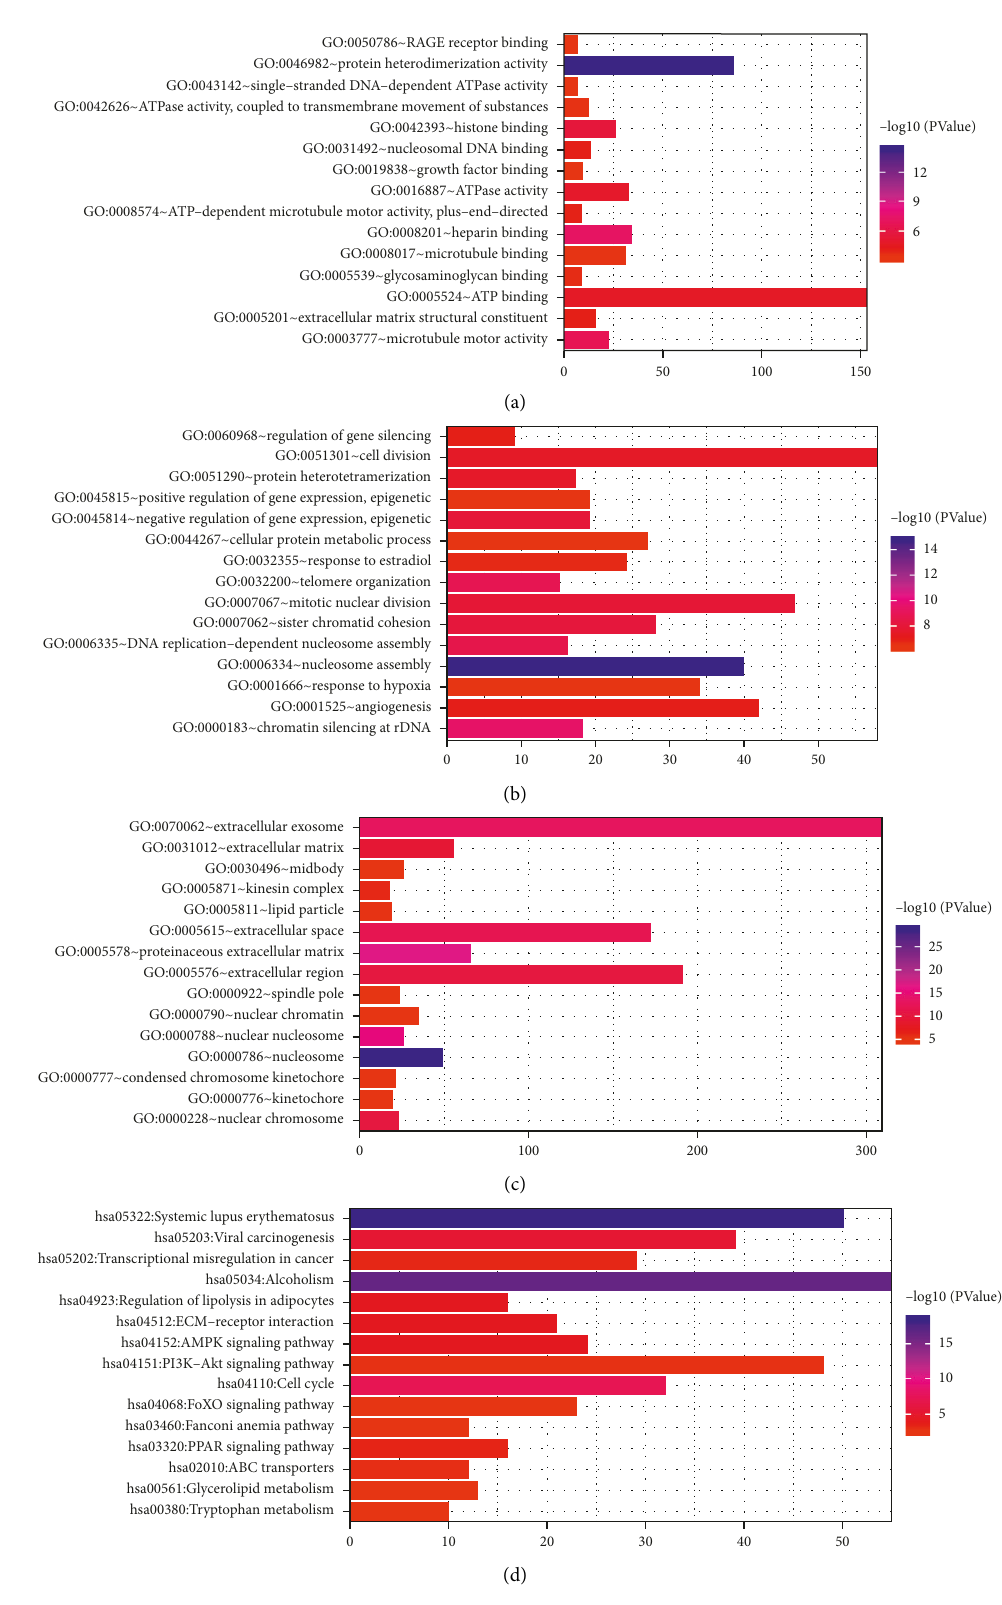
Figure 2: Top 15 significantly enriched GO terms and KEGG pathways in luminal A breast cancer. (a) Biological process, (b) cellular component, (c) molecular function, and (d) KEGG